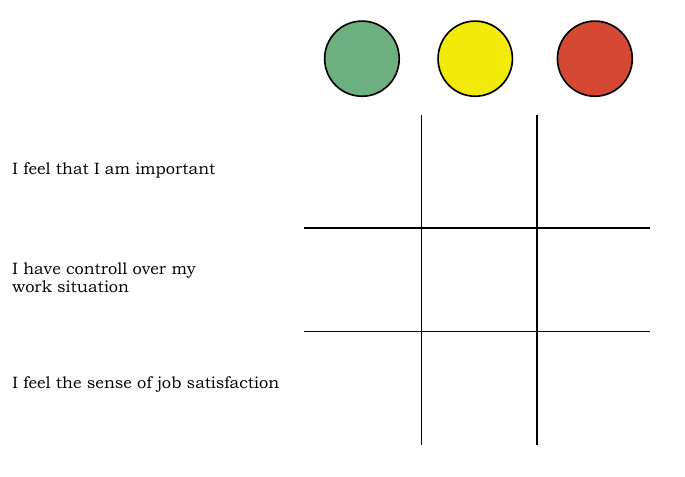
Figure 2. A signaling system: “people who